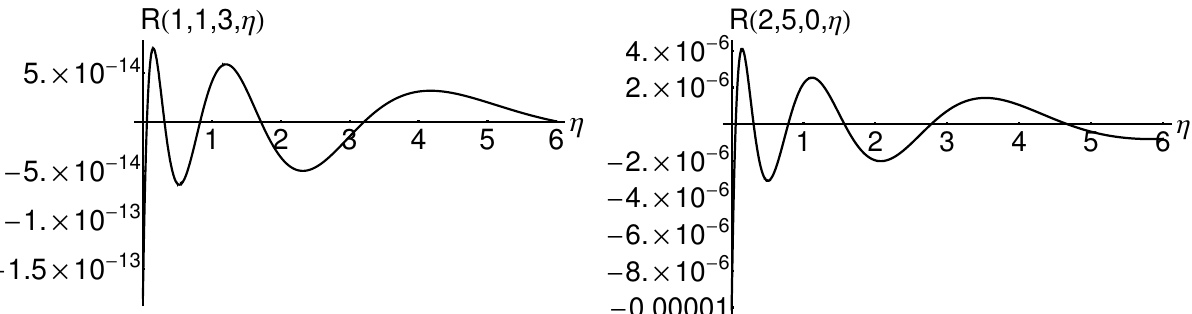
Figure 17: The residual R (2, 1, 0, η ) for Eq. (53) obtained by OAFM